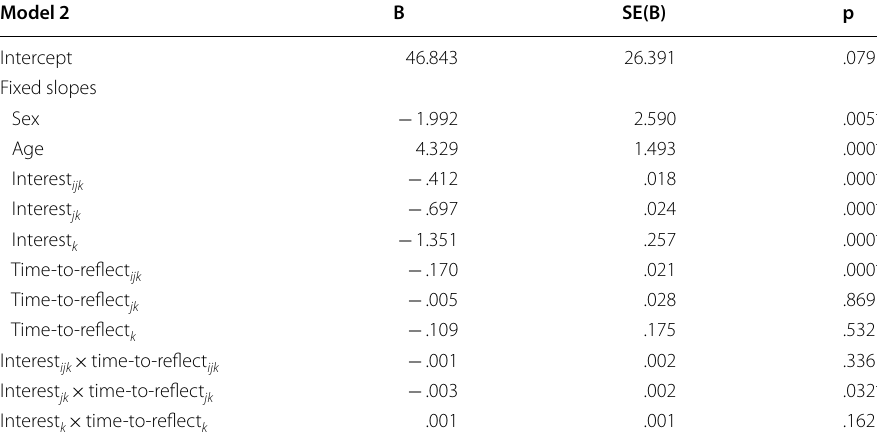
Table 4 Within-level interactions of control and value appraisals